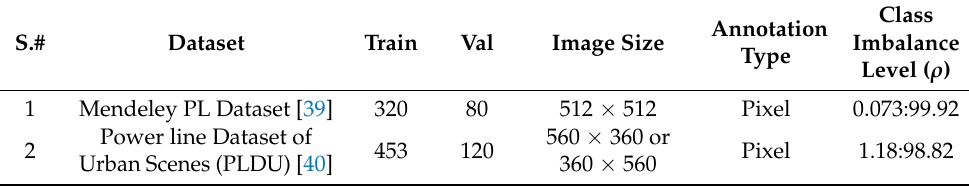
Table 1. Detailed information of the power line (PL) detection datasets used in this